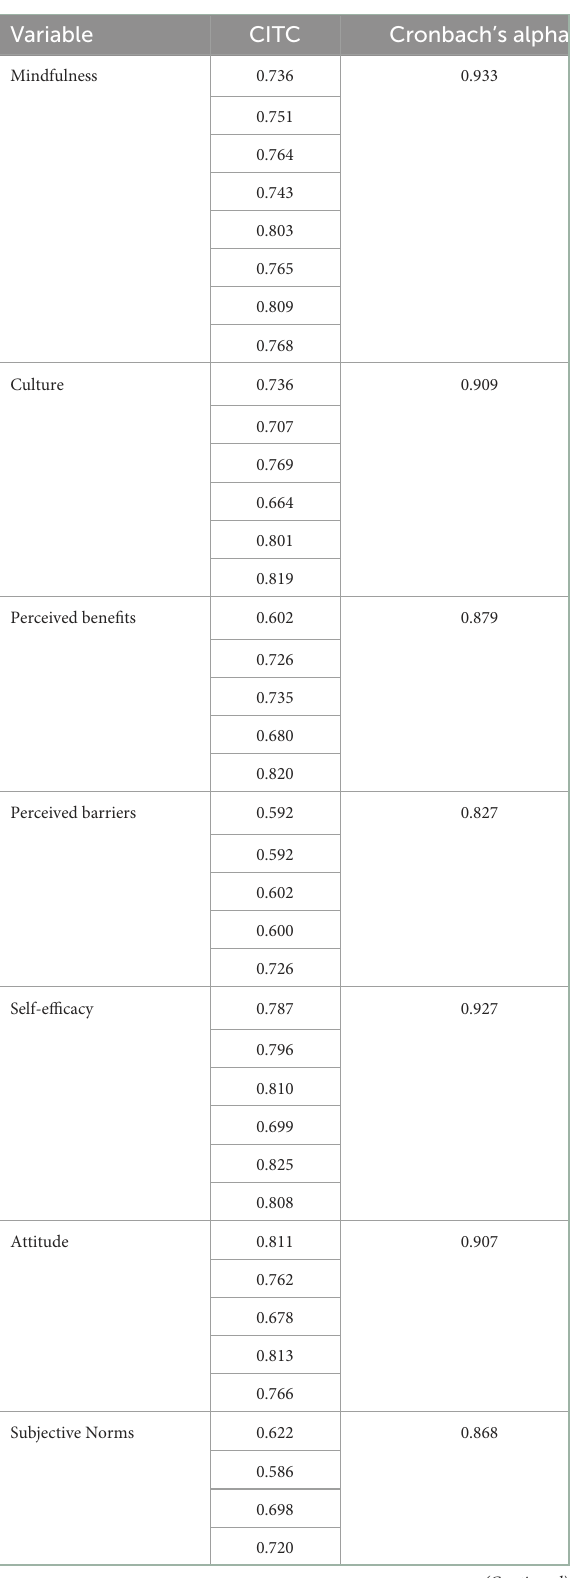
TABLE 3a Reliability test